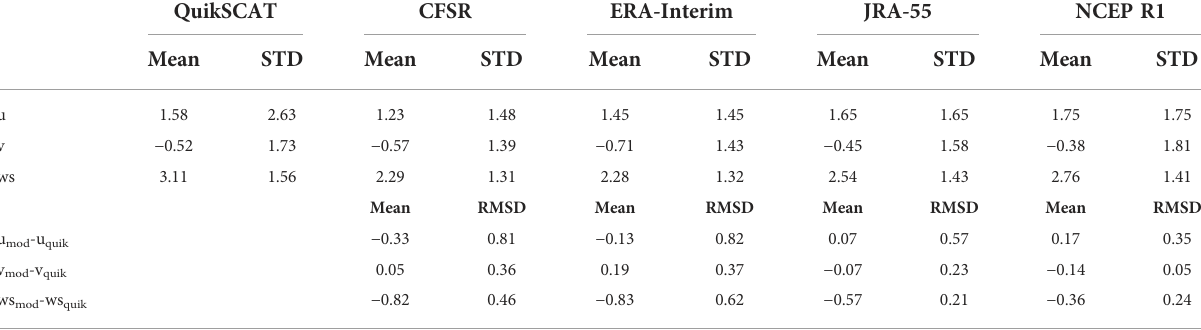
TABLE 3 Mean zonal wind speed (u), meridional wind speed (v), and total wind speed (ws) together with their standard deviations for QuikSCAT, CFSR, ERA-Interim, JRA-55, and NCEP R1 dataset, as well as the mean and root mean square deviation (RMSD) between the reanalysis